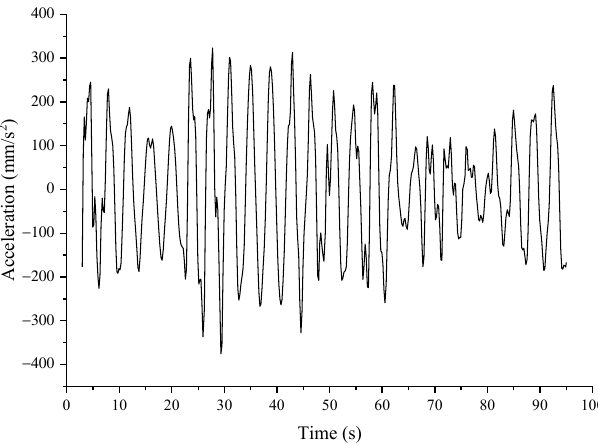
Figure 18. Response accelerations of the hub under ultimate ice conditions (ice thickness was 0.32 m and ice velocity was 0.75 m·s − 1 ).